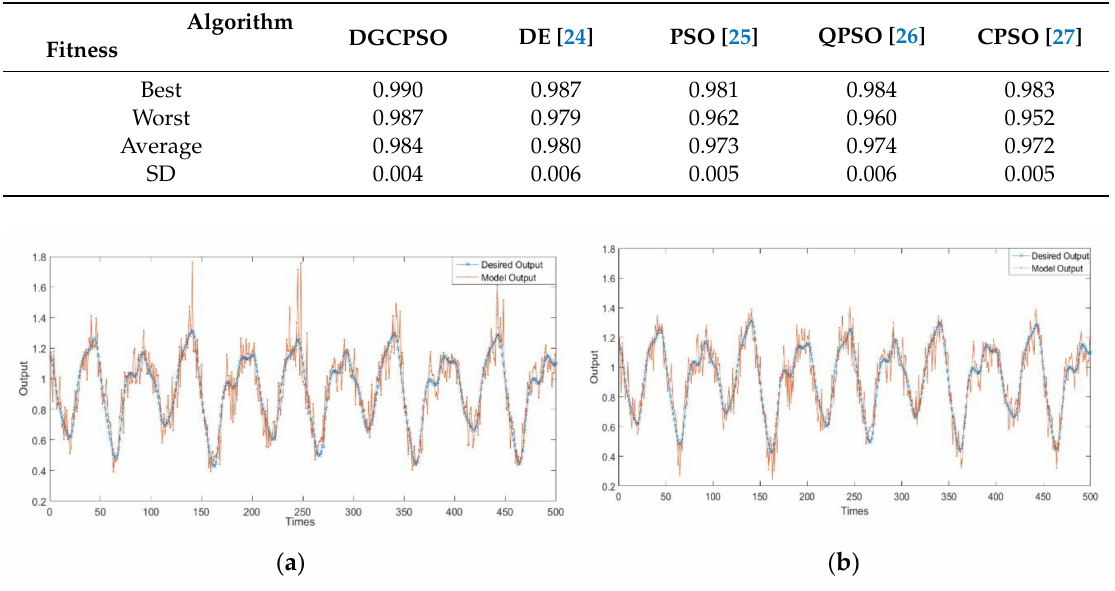
Table 4. Chaotic time-series performance of various algorithms.